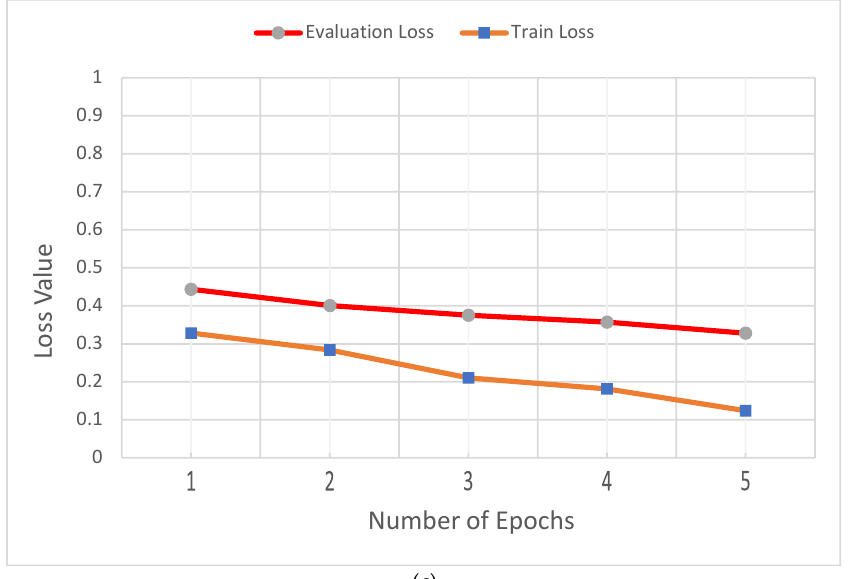
Figure 6. Performance of BART large model for SPoC dataset. ( a ) Accuracy of evaluation, test, and train datasets. ( b ) BLEU of evaluation, test, and train datasets. ( c ) Loss of evaluation and train dataset.